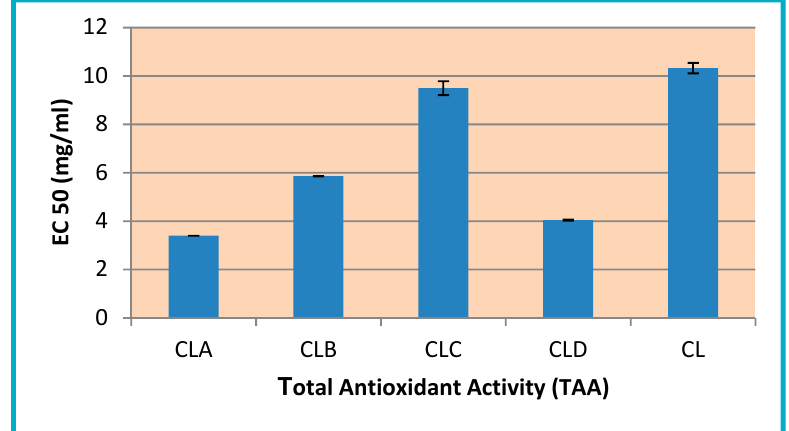
Figure 3. Total antioxidant activity (EC50 mg / mL) of chitosan nanoparticles and its derivatives (CL, CLA-CLD).